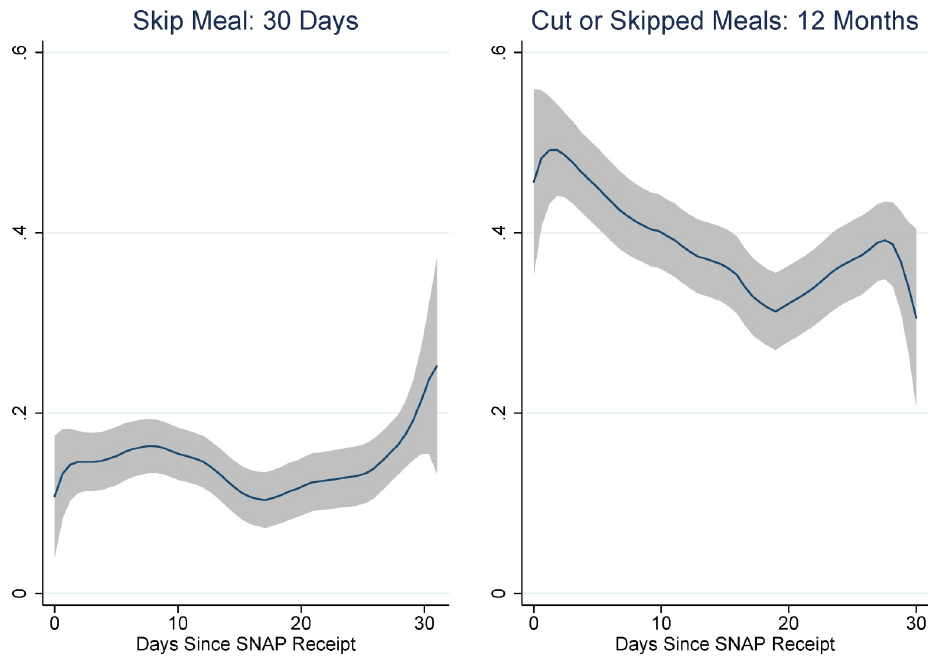
Fig 4. Individual 30-day and household 12-month response to cut/skip FSM item and days since SNAP. Source: Authors’ calculations using NHANES data. N = 2,216. Non-parametric regression estimates are weighted.